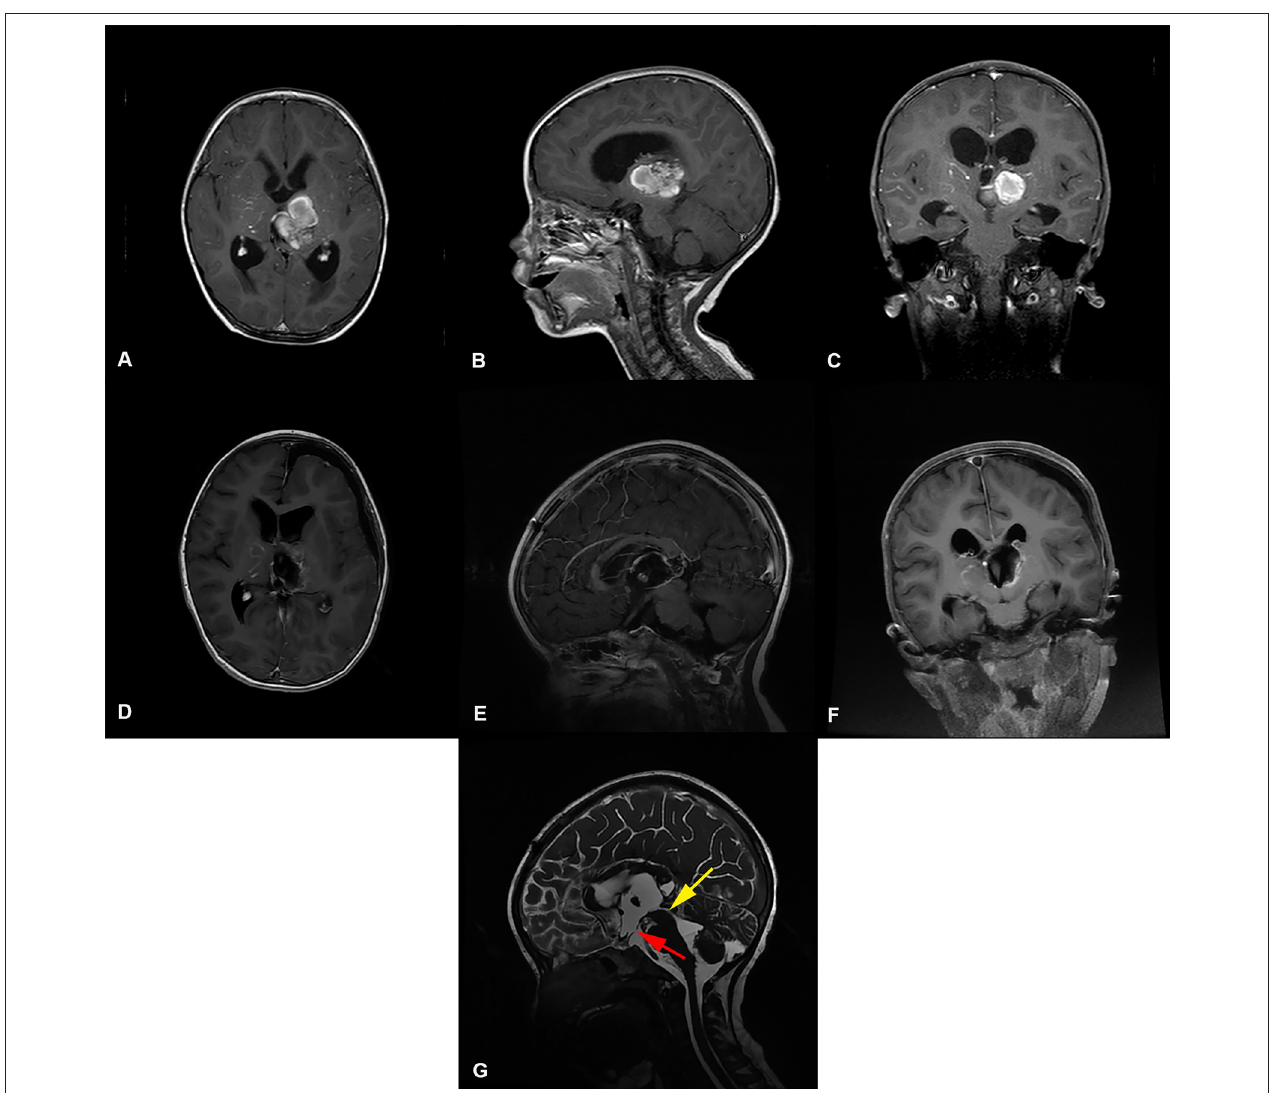
FIGURE 3 | Preoperative and postoperative imaging of thalamic cavernous hemangioma resection with left trans-frontal lateral ventricle approach + third ventriculostomy. (A-C) display: Axial, sagittal and coronal enhanced MRI of benign tumors of the left thalamus. The MRI shows that the main body of the tumor was located in the left thalamus, invading the third ventricle, and the supratentorial lateral ventricle and third ventricle were dilated. (D-F) display: MRI images of thalamic tumor resection with left trans-frontal lateral ventricle approach + third ventriculostomy. The images show total resection of the tumor; the volume of the lateral ventricle after surgical resection of the thalamic lesion did not expand. (G) display: Three ventriculostomy was performed after resection of thalamic tumor The MRI T2 shows that the upper mouth of the midbrain aqueduct was thin, as indicated by the yellow arrow( ). The position indicated by the red arrow ( ) is the leak at the bottom of the third